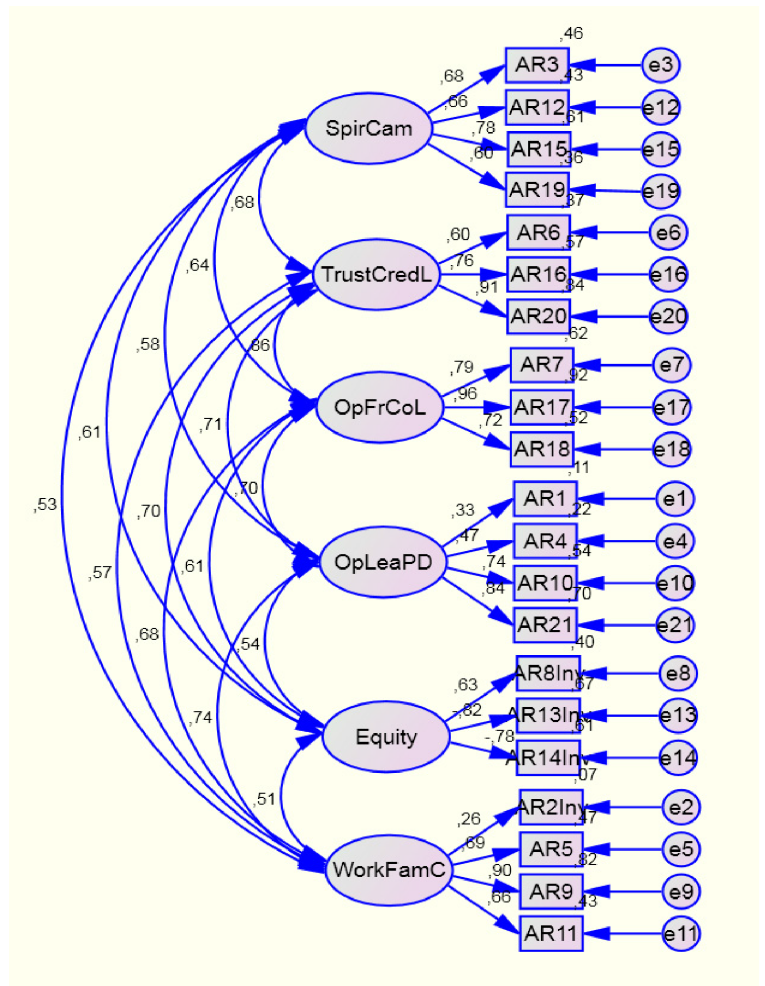
Figure 1. Confirmatory factor analysis. Authentizotic dimensions